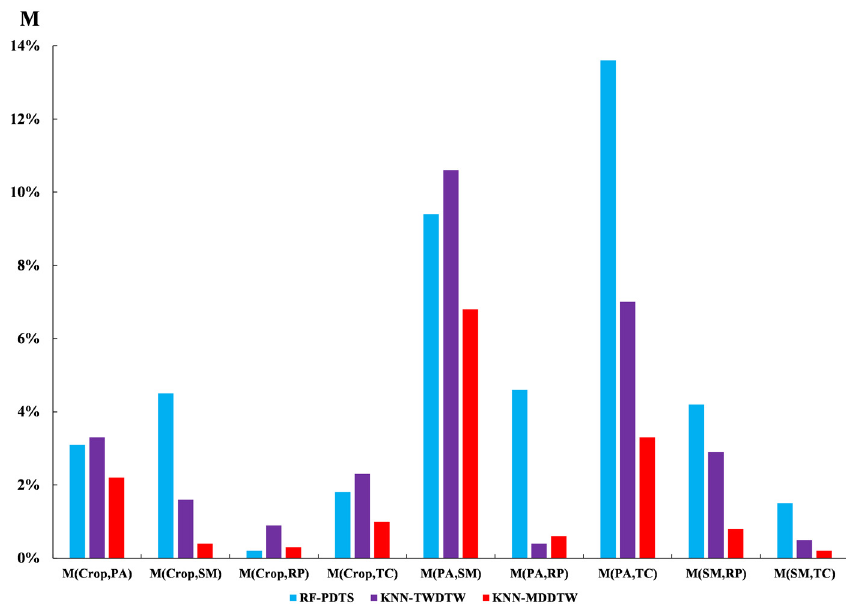
Figure 13. Misclassification of different vegetation with different methods.